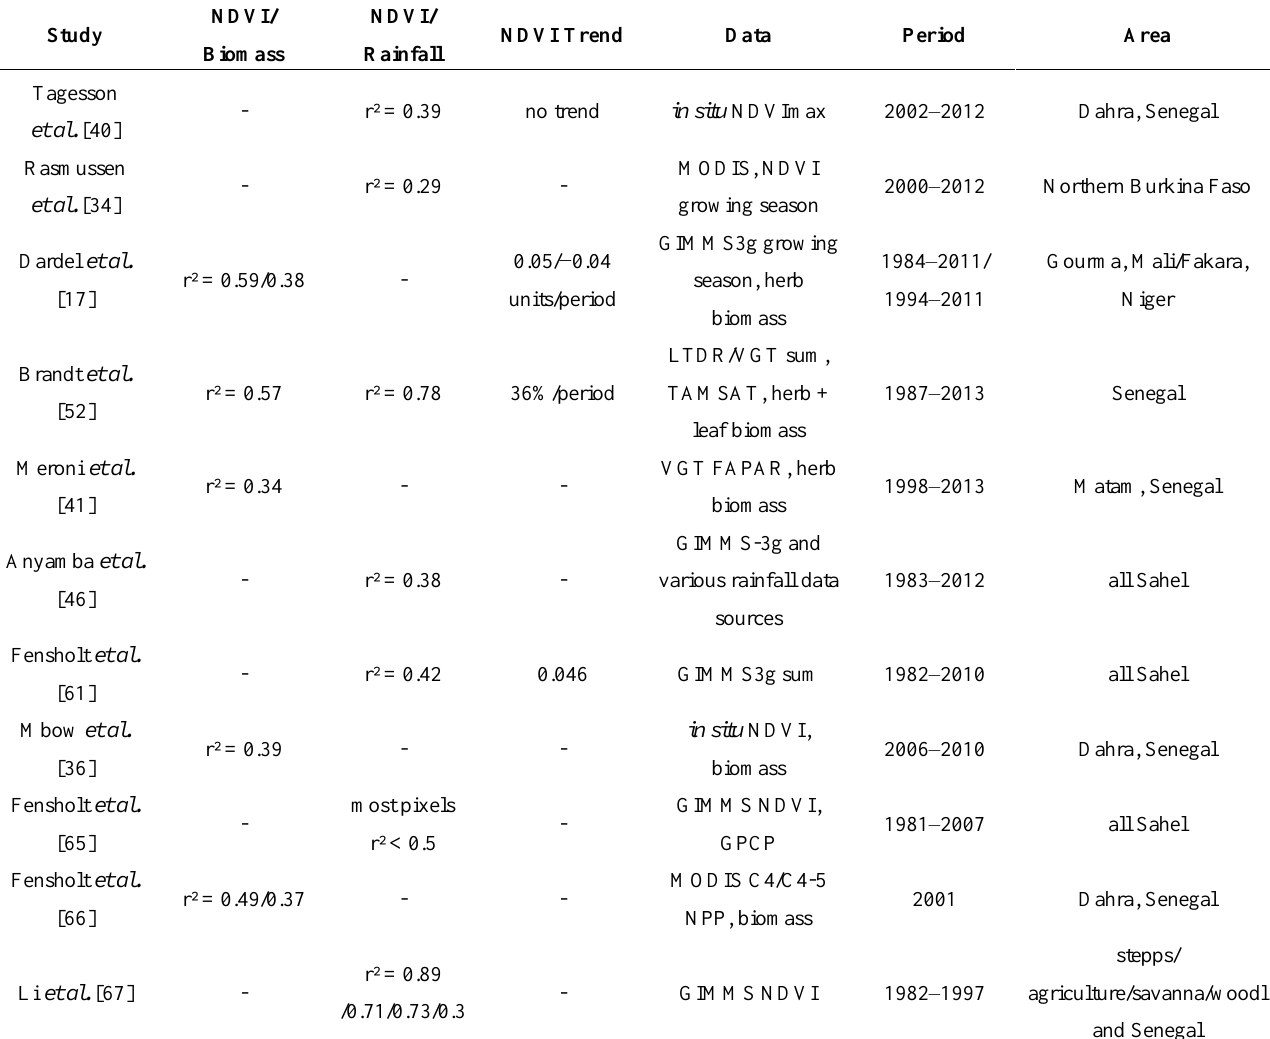
Table 1. Correlation coefficients between NDVI, rainfall and biomass in different studies in the Sahel from 1982 to 2013. Different data, scale and periods lead to varying